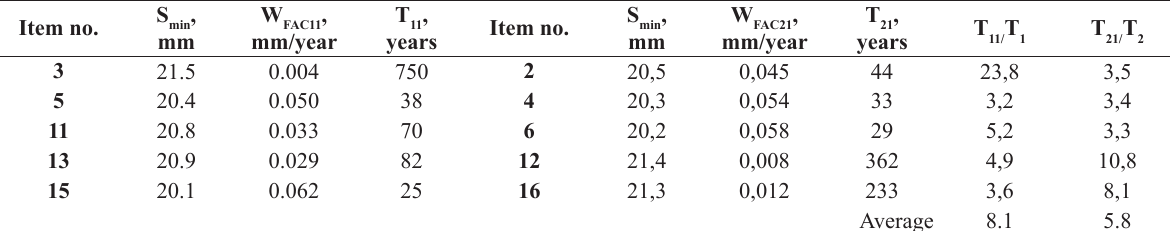
) and outlet ( W ) without correction coefficients. FAC11 FAC21